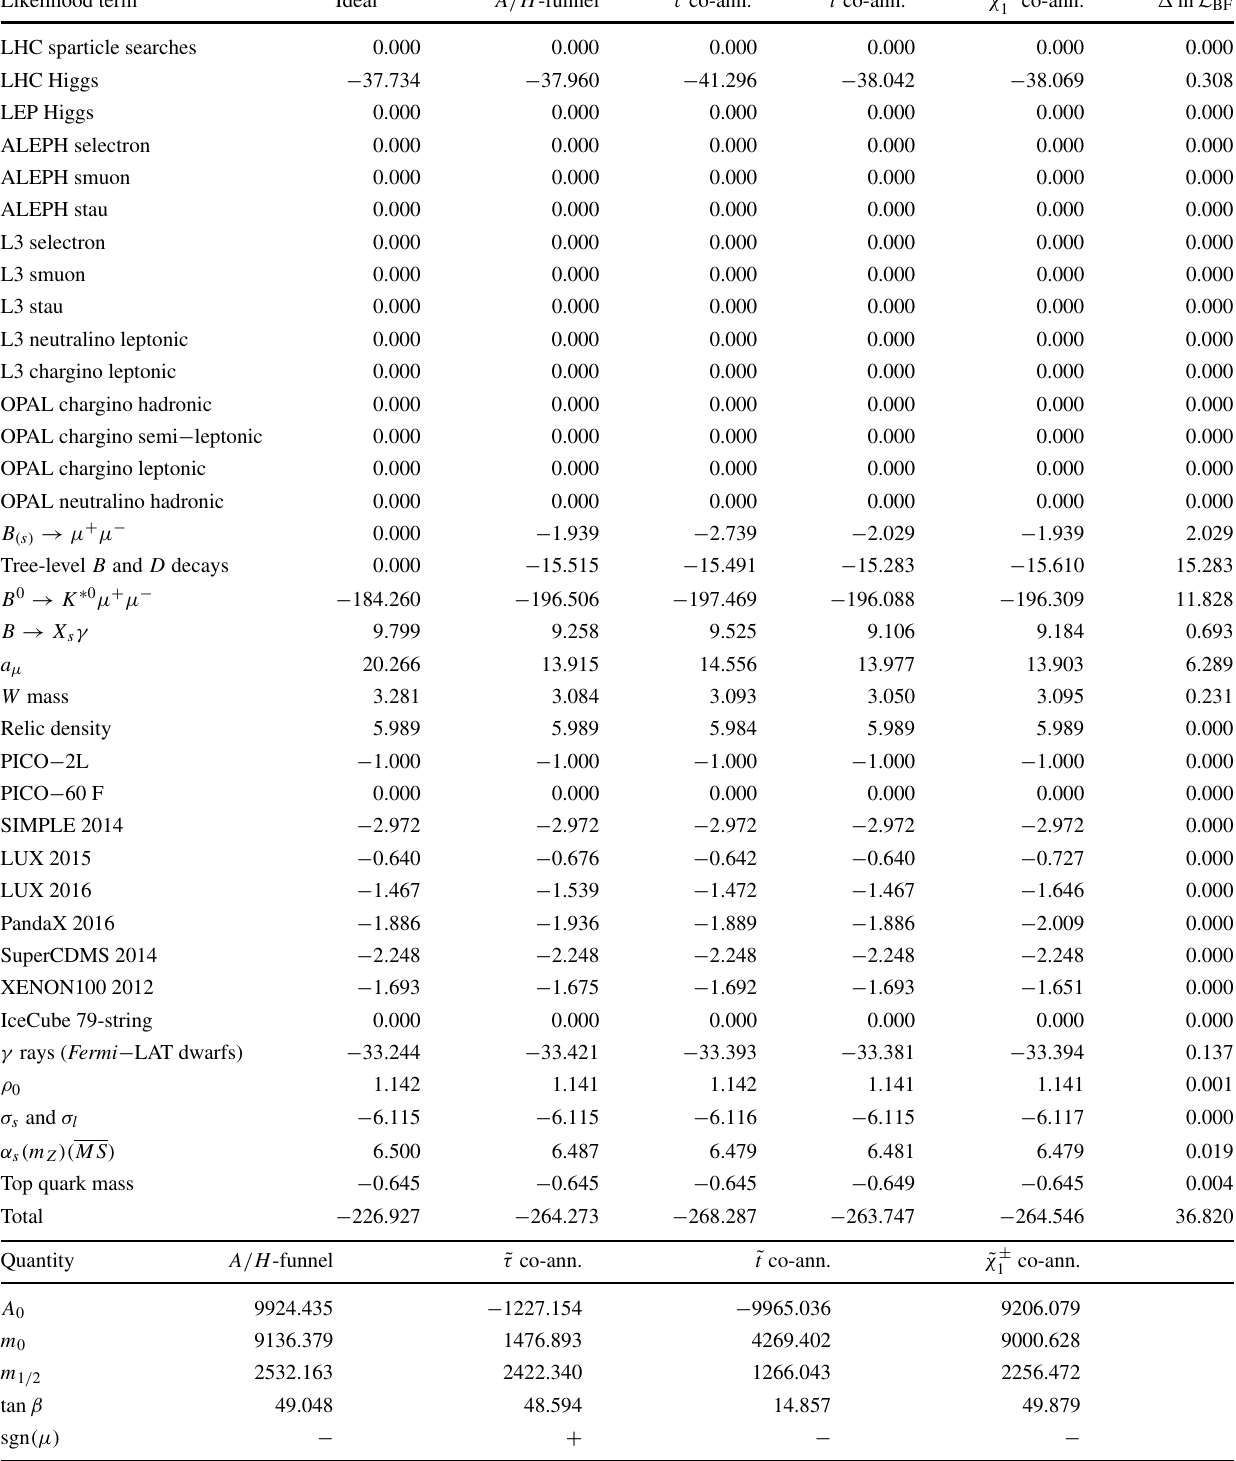
Table 5 Best-fit points in the CMSSM, for each of the regions charac- terised by a specific mechanism for suppressing the relic density of dark matter. Here we show the likelihood contributions, parameter values at each point, and some quantities relevant for the interpretation of mass spectra at the different best fits. We also give likelihood components